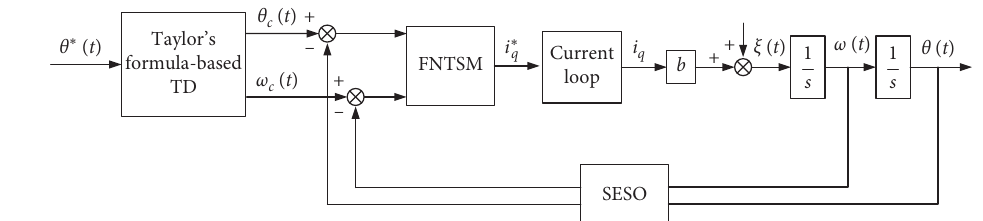
Figure 3: Parallel structure in position and speed control